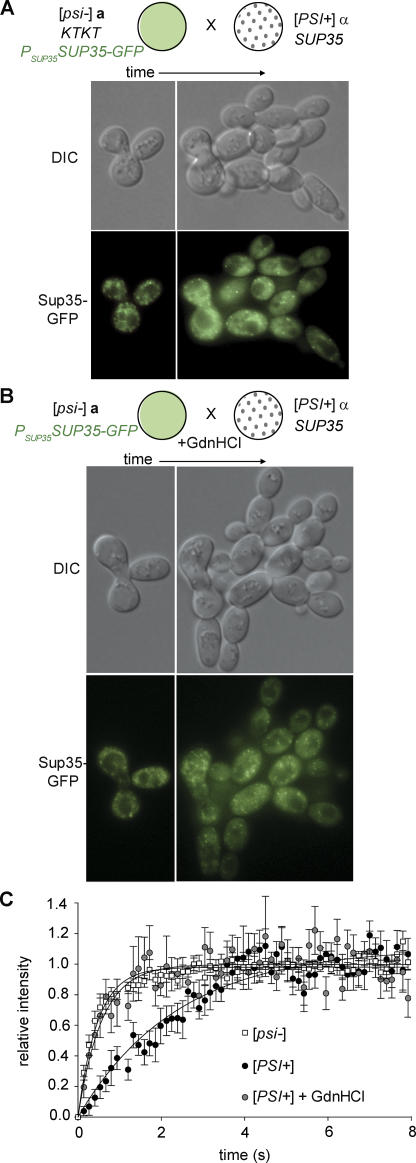
Newly Synthesized Sup35-GFP Is Inefficiently Incorporated into Limiting Prion Complexes Resulting from Hsp104 Inhibition and Cell Division(A) A MATa [psi−] haploid with KTKT and SUP35GFP chromosomal replacements (SY751) was mated to a MATα [PSI+] haploid constitutively expressing SUP35 (SY581) as shown in the diagram (top). Representative images of a zygote and microcolony derived from this zygote are shown (n = 7).(B) A MATa [psi−] haploid with a SUP35GFP chromosomal replacement (SY87) was mated to a MATα [PSI+] haploid constitutively expressing SUP35 (SY581) in the presence of GdnHCl as shown in the diagram. Representative images of a zygote and microcolony derived from this zygote are shown (n = 7). Under these conditions, the isolated zygote (left, [A] and [B]) continues to express Sup35-GFP, but lacks functional Hsp104.(C) FRAP recovery curves for [psi−] (SY360, white squares), [PSI+] (SY597, black circles) and [PSI+] cells after treatment with GdnHCl for 16–24 h (SY597, gray circles), which all constitutively express Sup35-GFP, are shown. The respective recovery times are: 0.33 s (R2 = 0.93), 1.16 s (R2 = 0.95), and 0.39 s (R2 = 0.79).